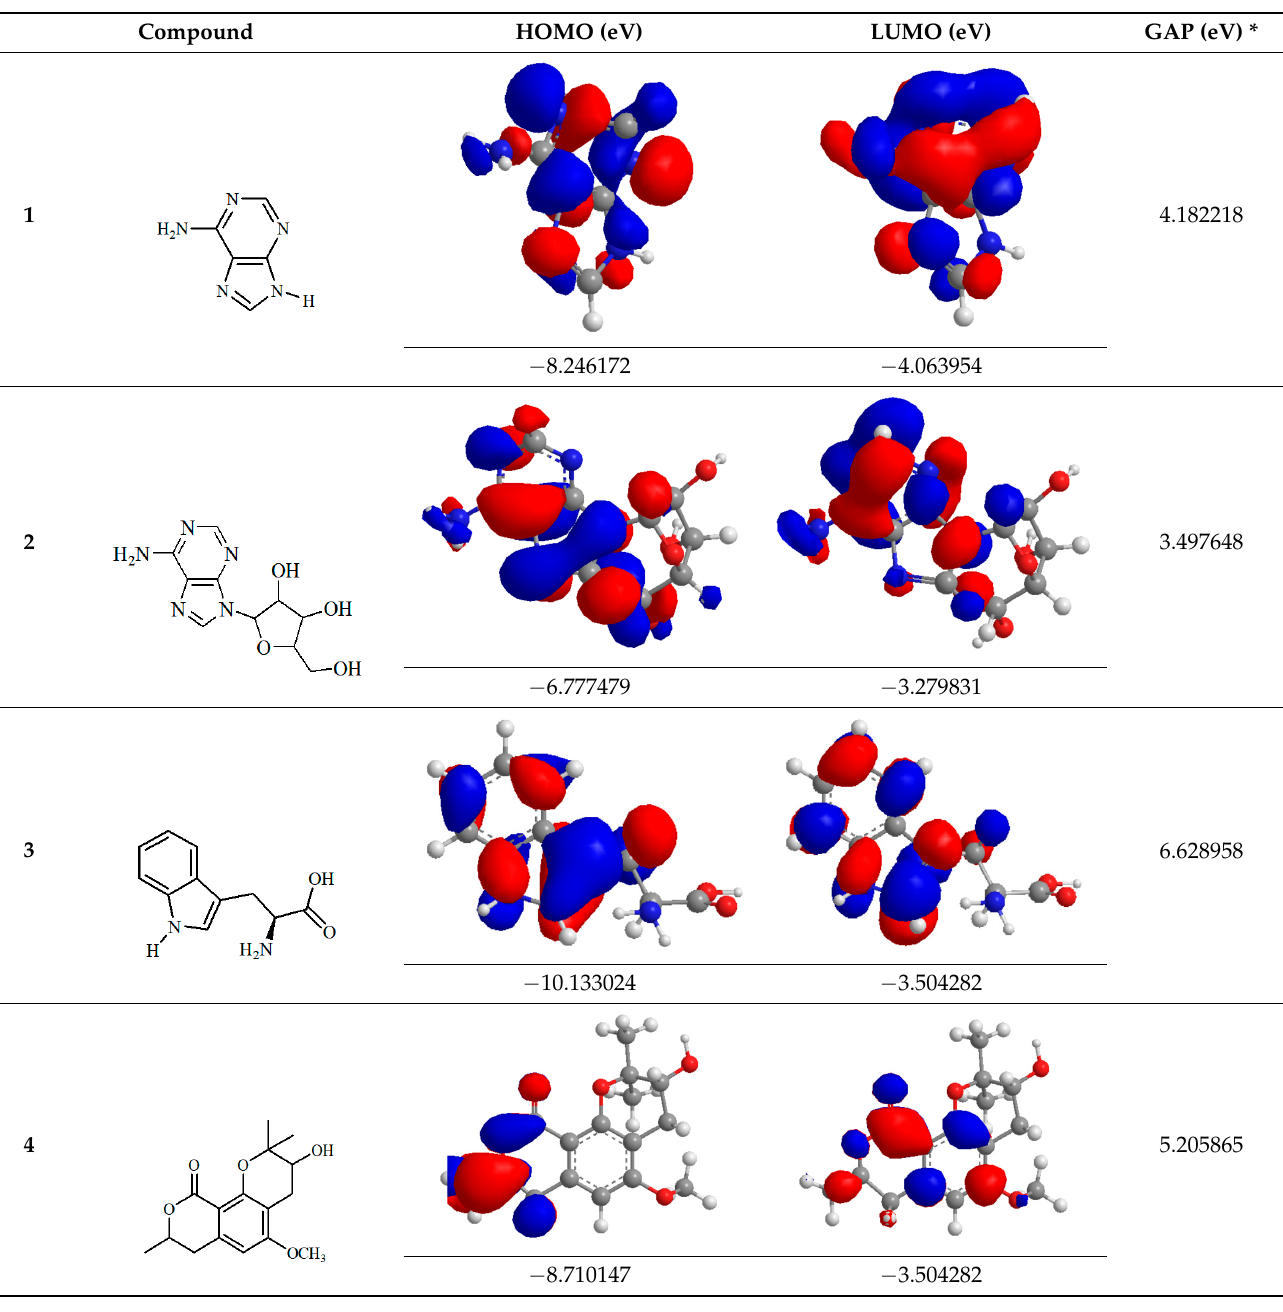
Table 3. Frontier orbitals calculated for compounds 1–6 and their GAP values .